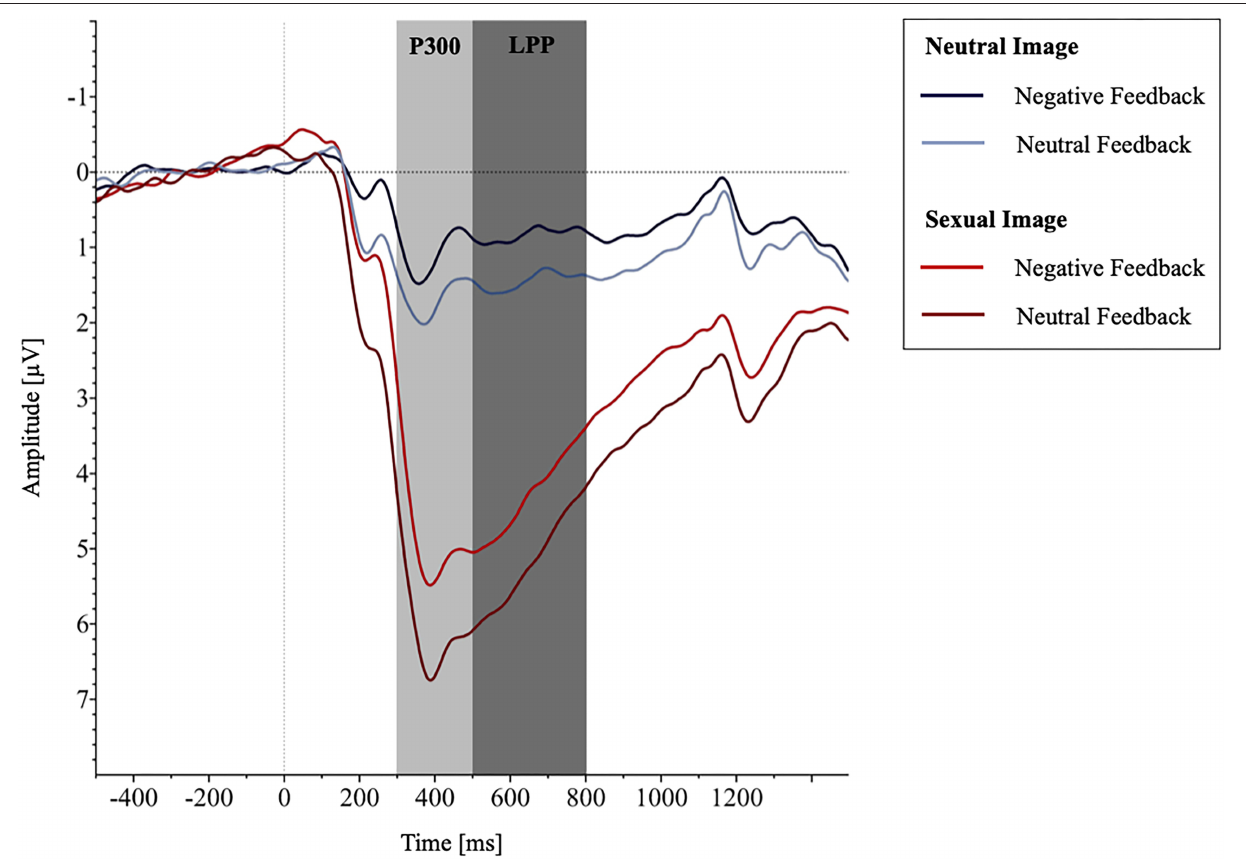
FIGURE 3 | The grand average waveforms averaged across channel CP1, CP2, P3, Pz, and P4 showing the potentials produced in response to the presentation of sexual vs. neutral images depending on group